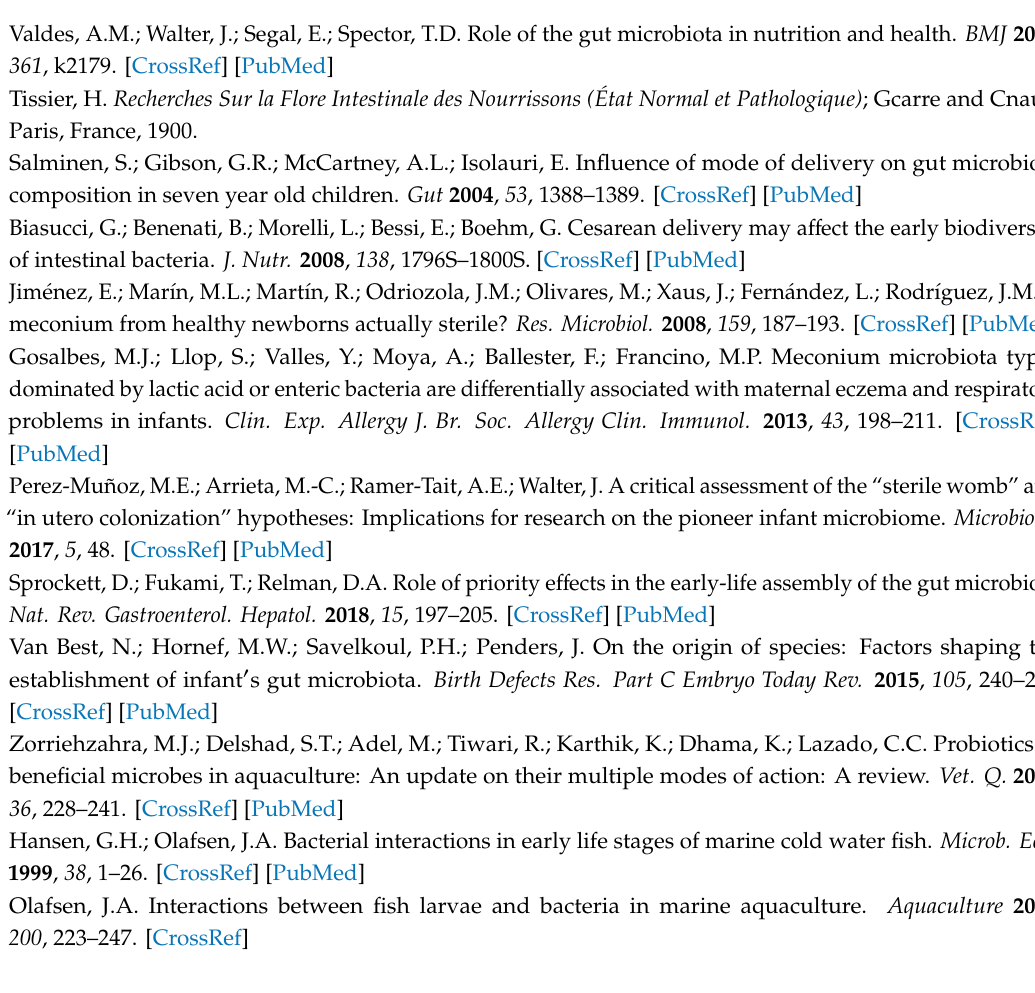
Table S1: Individual sequence reads of the investigated developmental stages of Sparus aurata larvae. Table S2: Comparison of rarefied (R) and non-rarefied (NR) data performance of the bacterial operational taxonomic units (OTUs) in all the investigated developmental stages of Sparus aurata larvae. Figure S1: Rarefaction curves of the sequencing reads in all individual samples, Figure S2: Clustering of bacterial communities at the operational taxonomic units level Sparus aurata larvae and the surrounding environment microbial populations. UPGMA clustering was performed on weighted and unweighted UNIFRAC measures between samples based on phylogenetic and OTU distribution distance matrices, Figure S3: Venn diagram of the shared operational taxonomic units between all the investigated developmental stages of Sparus aurata larvae, Figure S4: Mean relative abundance of proteobacterial classes in all sample categories (Sparus aurata larvae, rearing water and feeds) D: Day, AM: Artemia salina metanauplii, AN: Artemia salina nauplii, CD: Commercial diet, RT: Rotifers, W: Water sample., Figure S5: Percentage of shared operational taxonomic units between Sparus aurata larvae and the surrounding environment microbial